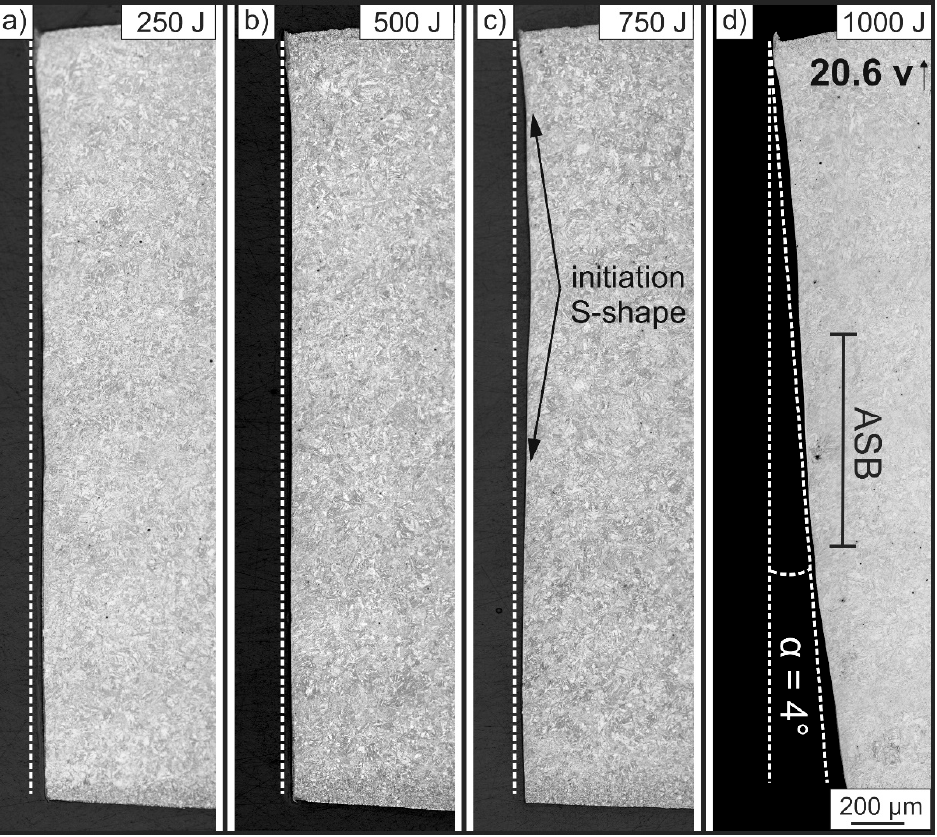
Figure 8. Blanked surfaces of the sheet cut with a relative clearance of 10% (sample 20.6 v ↑ ) and varying impact energies from ( a ) 250 J, ( b ) 500 J, ( c ) 750 J to ( d ) 1000 J and velocities, respectively.